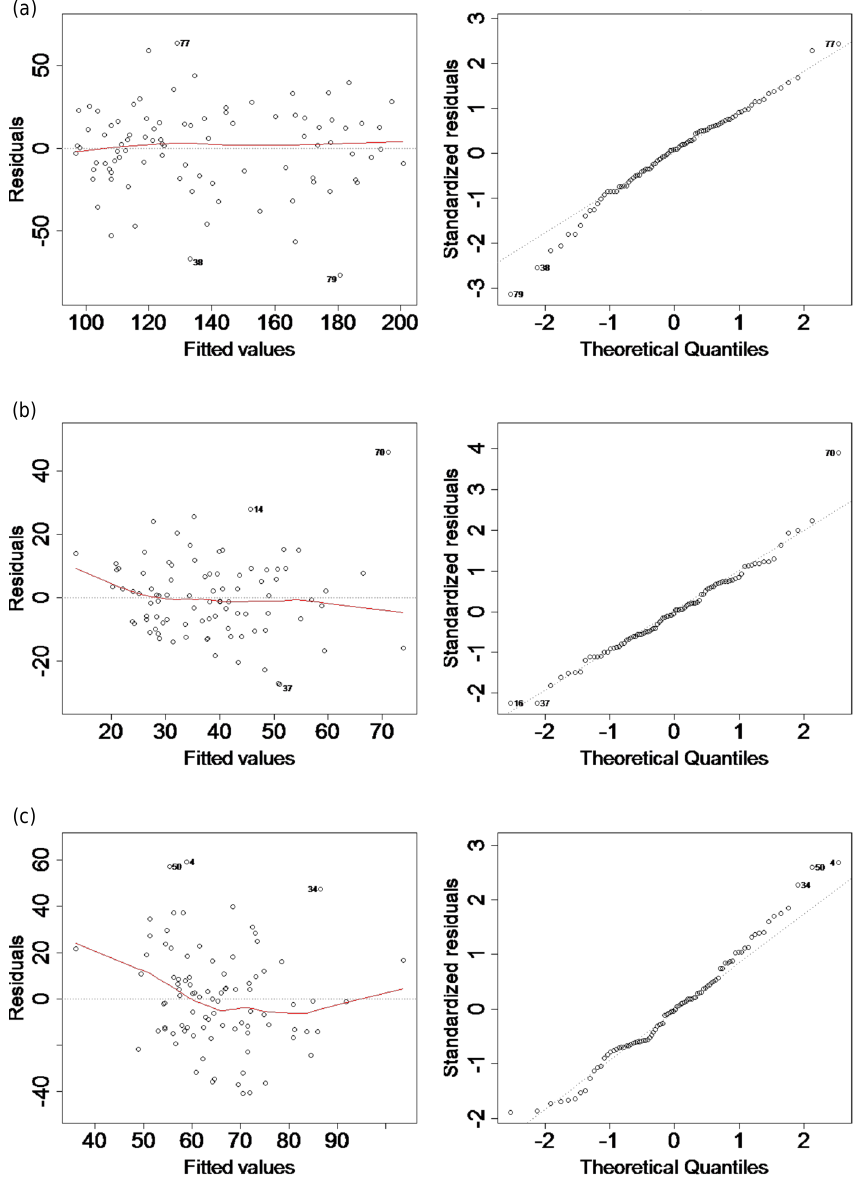
Figure 5. The same as in Fig. 4 but for